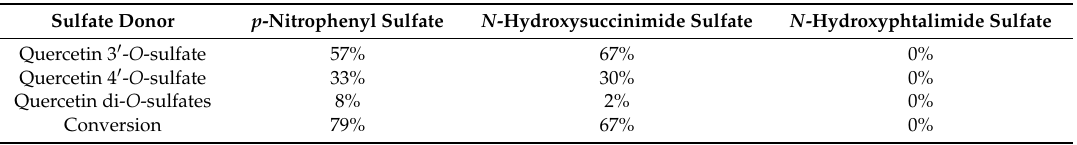
Figure 2. Structures of alternative sulfate donors. Table 1. Comparison of quercetin sulfation using alternative sulfate donors.